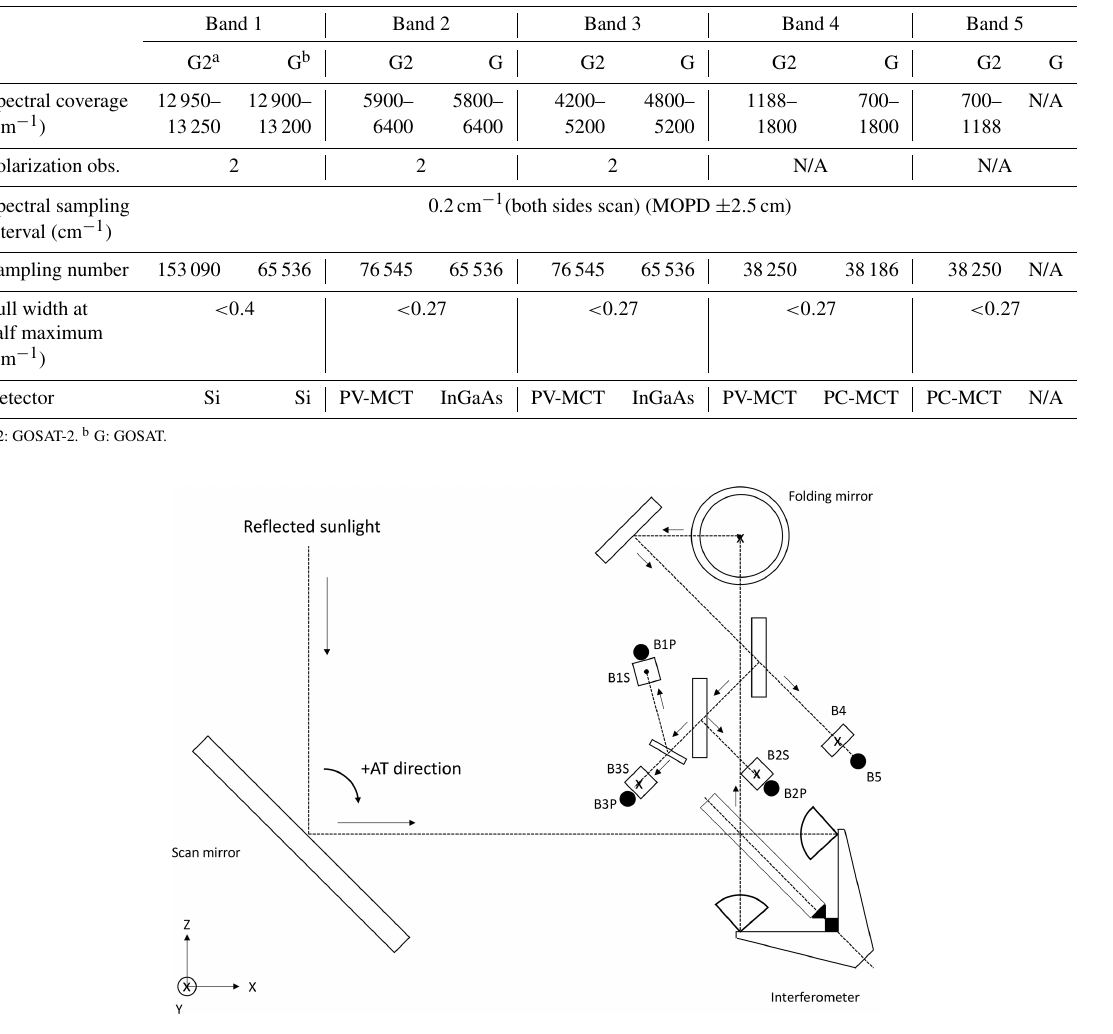
Figure 2. Schematic diagram for TANSO-FTS-2 optical layout.